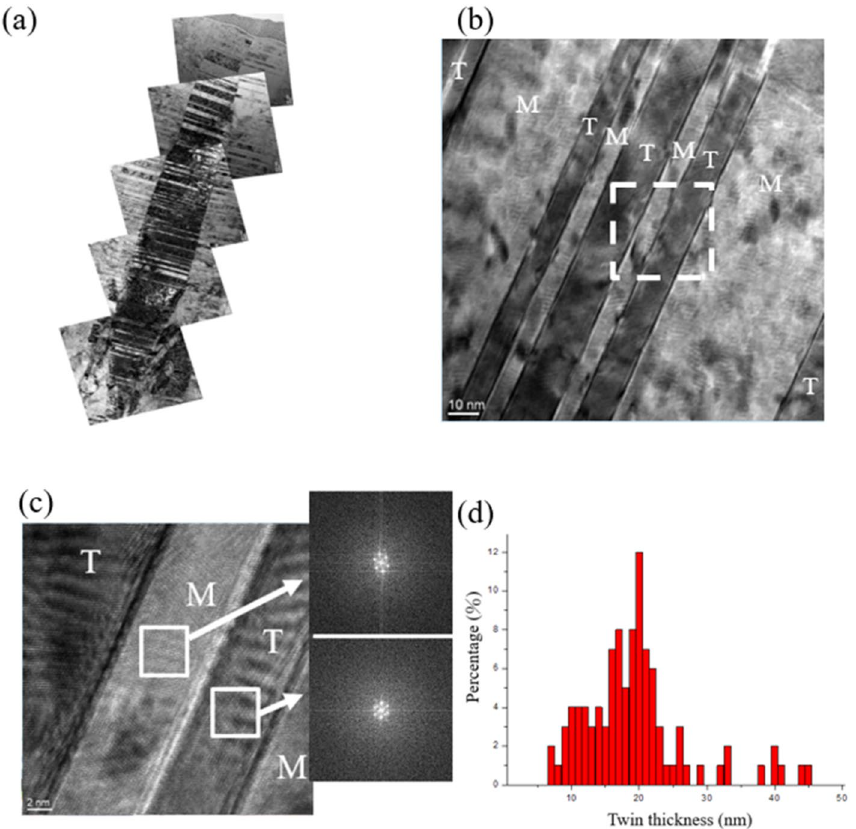
Figure 4. Cross-sectional TEM micrographs of as-deposited Cu nanotwinned film deposited with − 150 V bias: ( a ) bright-field TEM image of columnar Cu nanotwin ( b ) high resolution (HR) TEM image of nanotwinned structure ( c ) high magnification HRTEM image of nanotwinned structure from the white frame in ( b ) with different fast Fourier transformation (FFT) pattern of twin and matrix ( d ) distribution of twin thicknesses in the highly (111)-oriented Cu